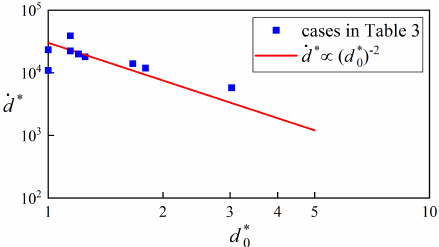
Figure 10. Normalized particle velocity vs. normalized initial distance for the cases in Table 2. The solid line represents a power law of − 2, which is predicted in Equation